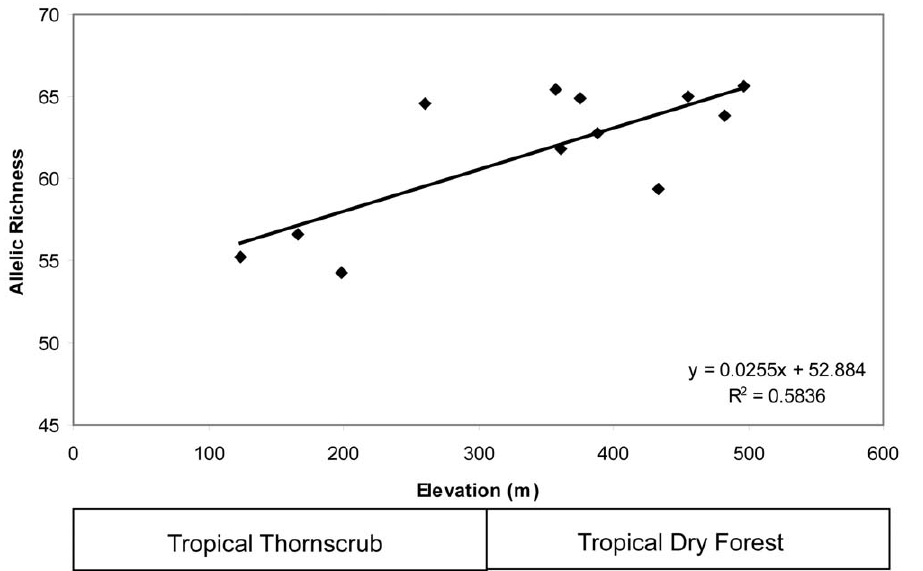
Figure 2. Relationship between elevation and genetic diversity (allelic richness) for all populations of Phyllodactylustuberculosus included in this study.